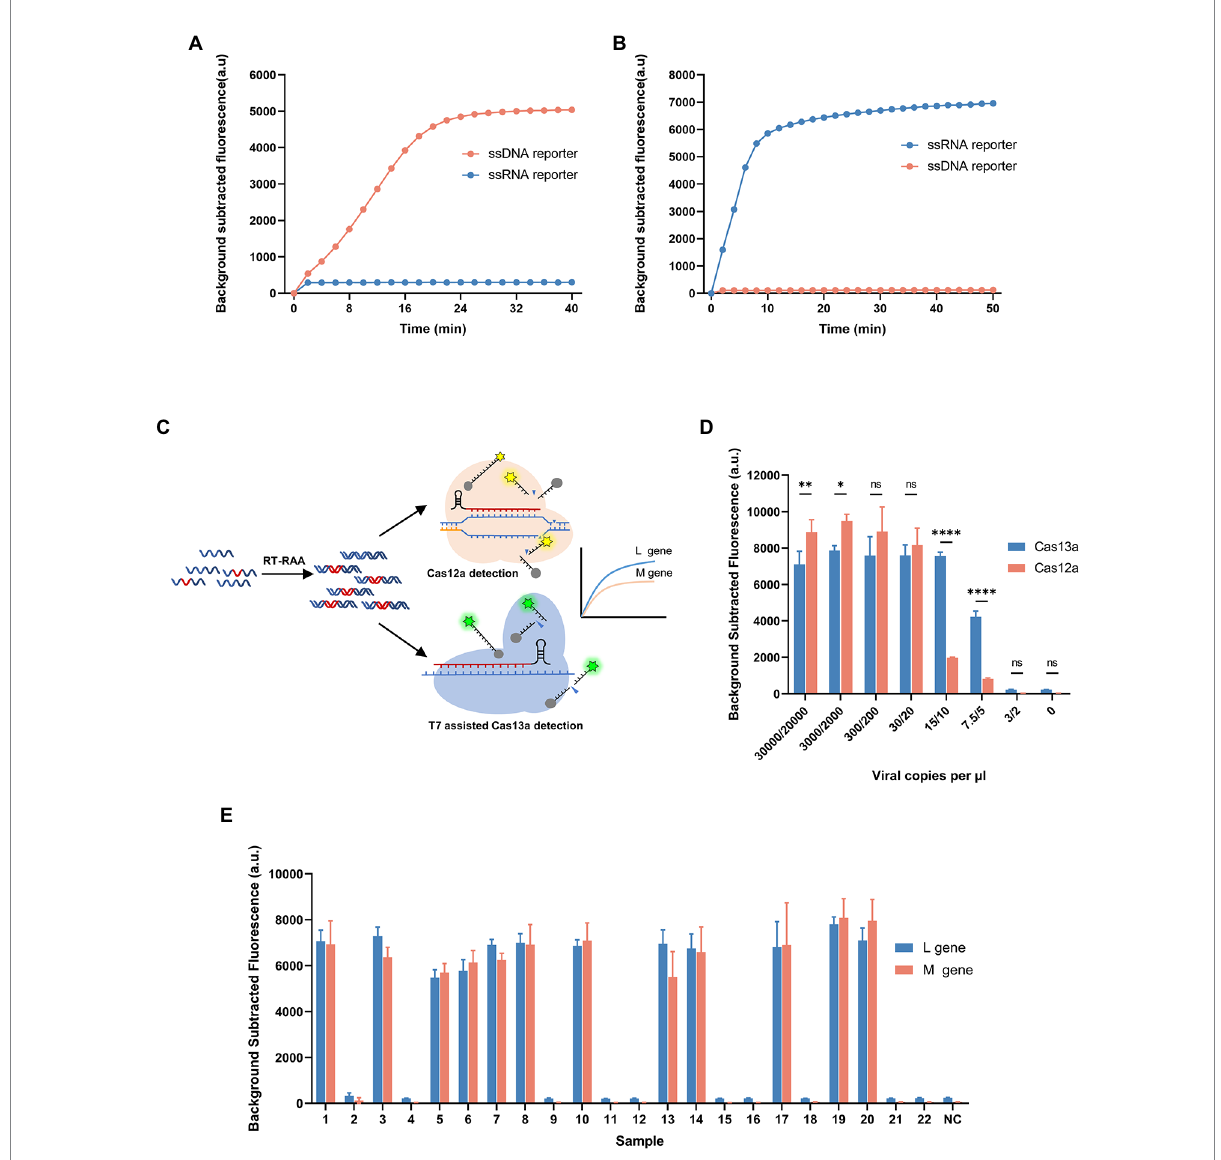
FIGURE 3 Development of dual-gene detection system for SFTSV. (A, B) Both ssDNA reporter (FAM-BHQ) and ssRNA reporter (VIC-BHQ) were added in the detection of Cas12a or Cas13a, and observed the changes in the two kinds of fluorescence intensity. Only the ssDNA reporter was cleaved by the activated Cas12a, and only the ssRNA reporter was cleaved by the activated Cas13a. (C) The schematic diagram of the dual-gene detection system for SFTSV with LbaCas12a and LwaCas13a. The L gene was detected in the FAM channel and M gene in the VIC channel. (D) Determination of the sensitivity of the multiplexed detection system using synthetic RNA standards after the condition optimization. The detectable signal at 10 cp/ μ l for Cas12a channel was weaker and unstable. Values represent mean ± SD ( n = 3). Statistical significance for comparison was determined using Two- way ANOVA and significance was considered as ns ≥ 0.05, * p < 0.05, ** p < 0.01, **** p < 0.0001. (E) The results of SFTSV detection in 22 clinical samples (12 positives and 10 negatives) using the multiplexed detection system. The L gene was detected by Cas13a using Cas13-L-crRNA1 and the M gene was detected by Cas12-M-crRNA8. Values represent mean ± SD ( n =